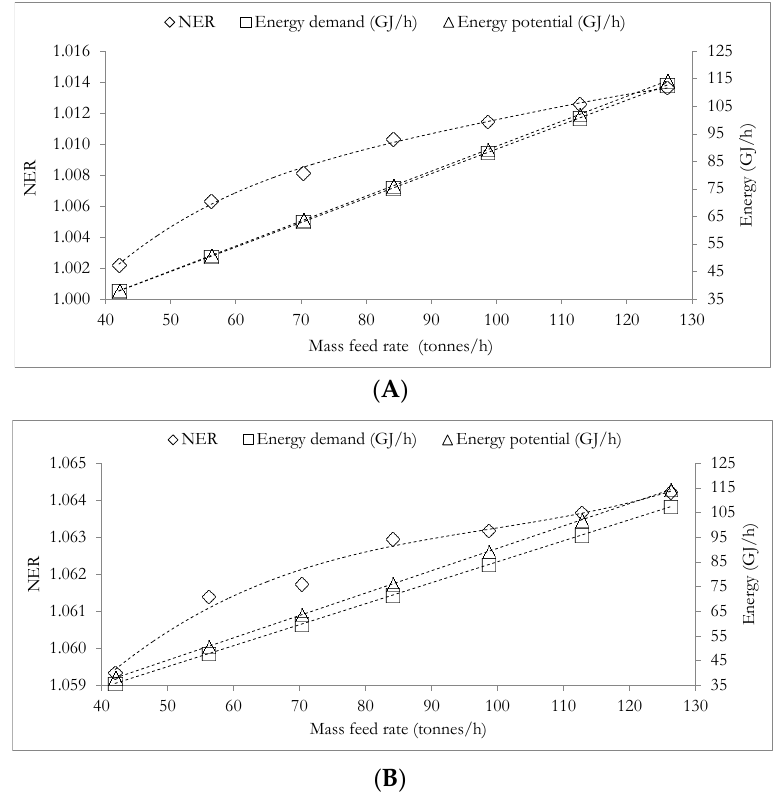
Figure 5. Dependence of NER, energy demand and energy potential on the mass feed rate of the total meat processing waste stream. ( A ) for case when electrical energy is generated from fossil sources and ( B ) for case when electrical energy is generated from renewable energy sources. Slight numerical fluctuations are responsible for the lack of perfect smoothness in NER versus the total meat processing waste stream ( B ).